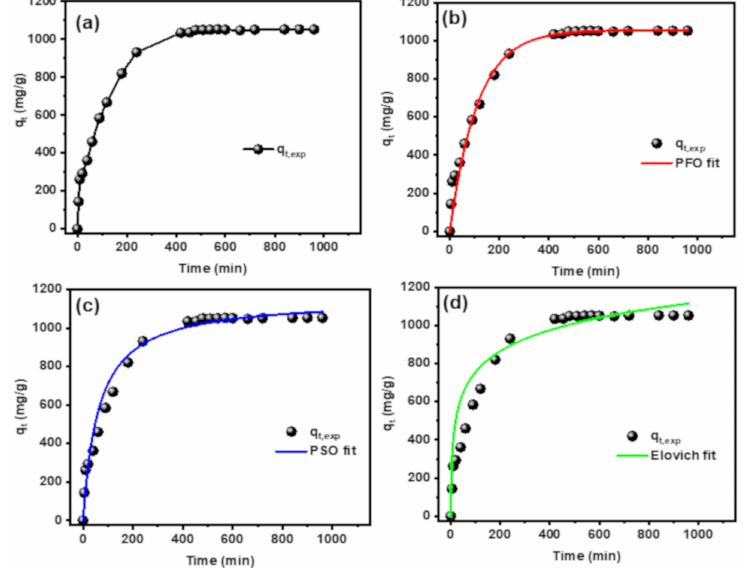
Figure 10. ( a ) E ff ect of the contact time on MB dye adsorption ( b ) non-linear Langmuir model, ( c ) non-linear Freundlich model, and ( d ) non-linear Elovich model. Table 2. Equations and parameters of non-linear Kinetic models of MB dye adsorption